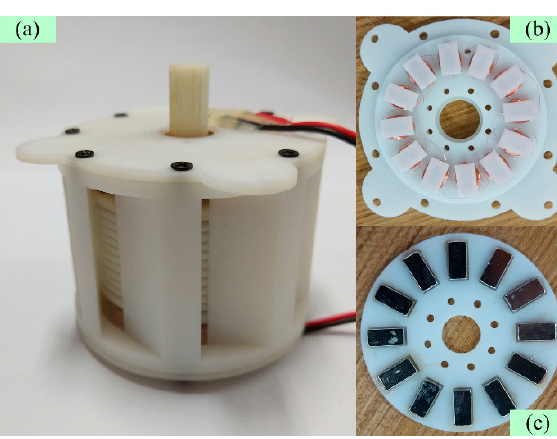
Figure 2. Photographs of flow energy harvester prototypes: ( a ) An assembled prototype; ( b ) Coils fixed in the end cap; ( c ) Permanent magnets mounted on the